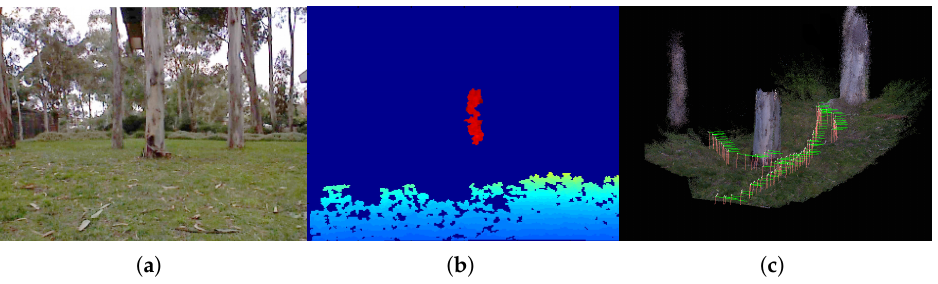
Figure 1. ( a ) A Kinect color image from an aerial vehicle, ( b ) showing partial depths from a tree trunk and the ground. ( c ) Reconstructed 3D map utilizing the direction constraints proposed in this